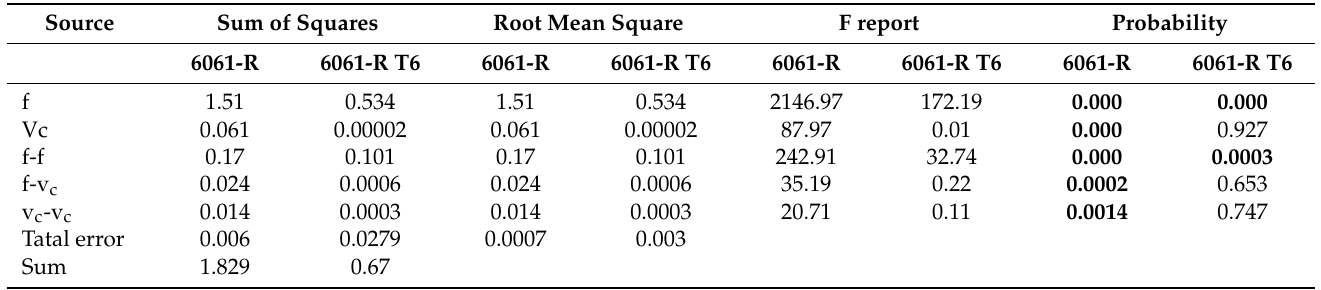
Table 6. Analysis of variance on surface roughness for 6061 R alloy and 6061 R-T6 alloy machined with lubrication.